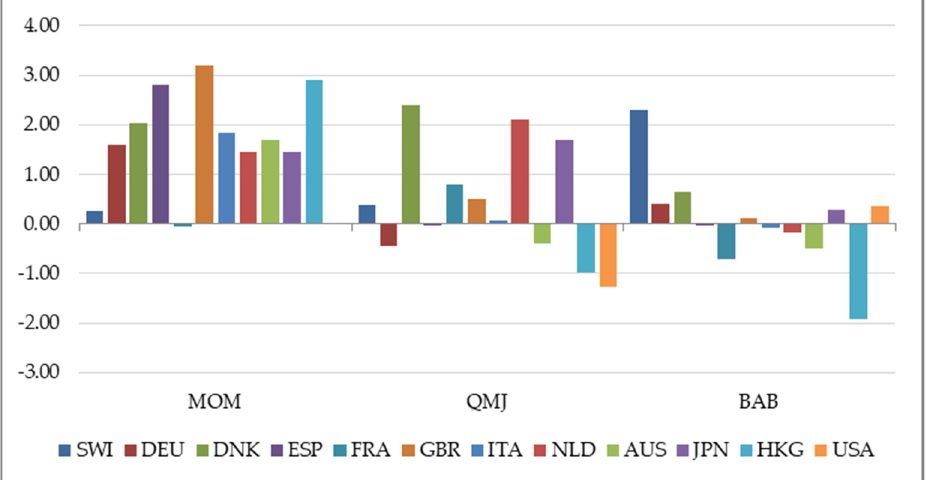
Figure 4. t -Statistics for the Fama–French Alphas for the Other Risk Factors: By Country. This figure displays t -statistics for testing the significance of the intercept from a regression of either the momentum factor (MOM), the quality factor (QMJ), or the betting-against-beta factor (BAB) on the three factors of the Fama–French (1993) model for representative stock markets around the world. See notes in Table 1. ( a ) shows the results when using monthly data for the first quarter of each of the years between 1997 and 2019, and ( b ) shows the results when using daily data for the subperiod affected by the first impact of the COVID-19 pandemic from January to March 2020.